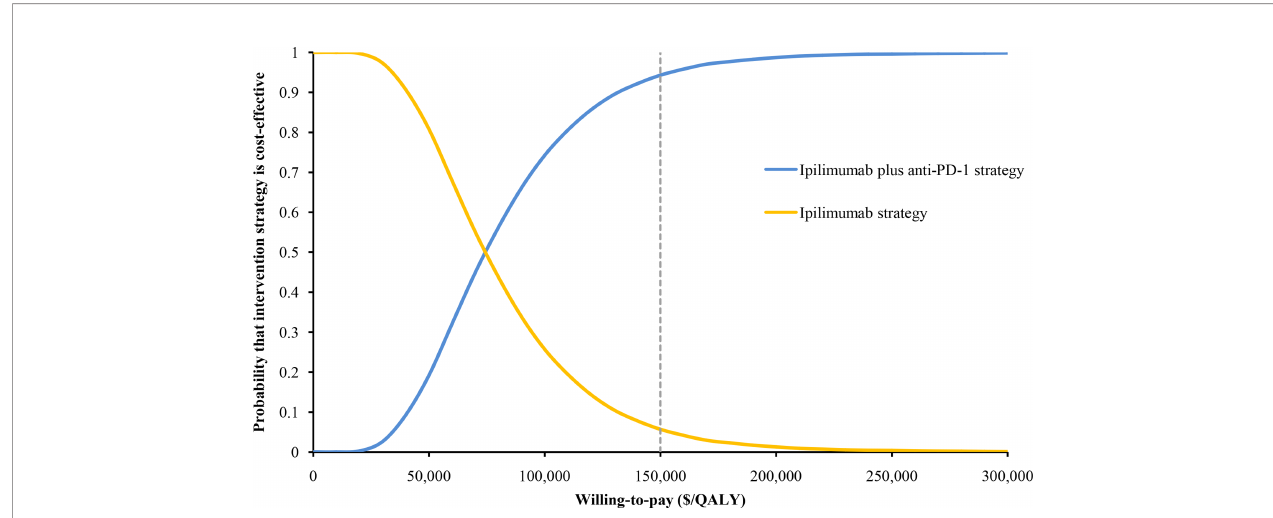
FIGURE 3 | The cost-effectiveness acceptability curve of ipilimumab plus anti-PD-1 strategy and ipilimumab strategy in patients with metastatic melanoma resistant to anti-PD-(L)1